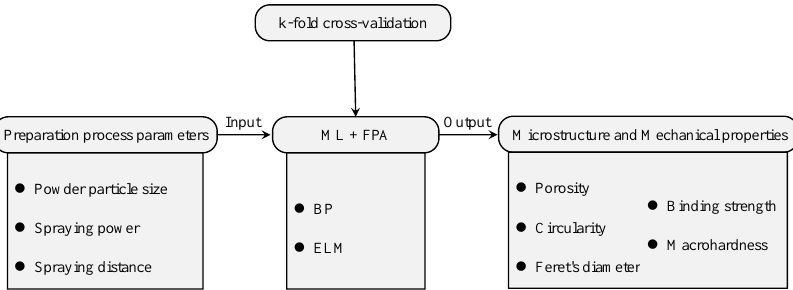
Figure 1. Research content structure diagram.